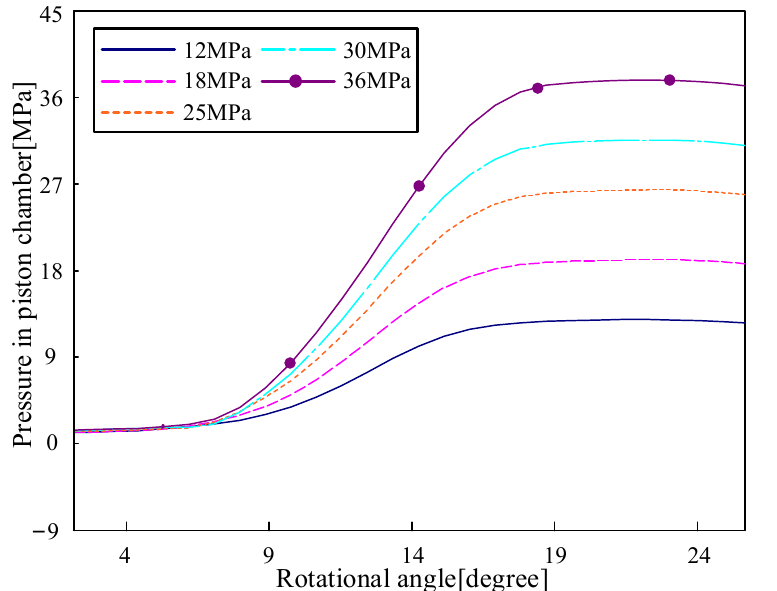
Figure 18. Pressure in piston chamber with different outlet pressure.